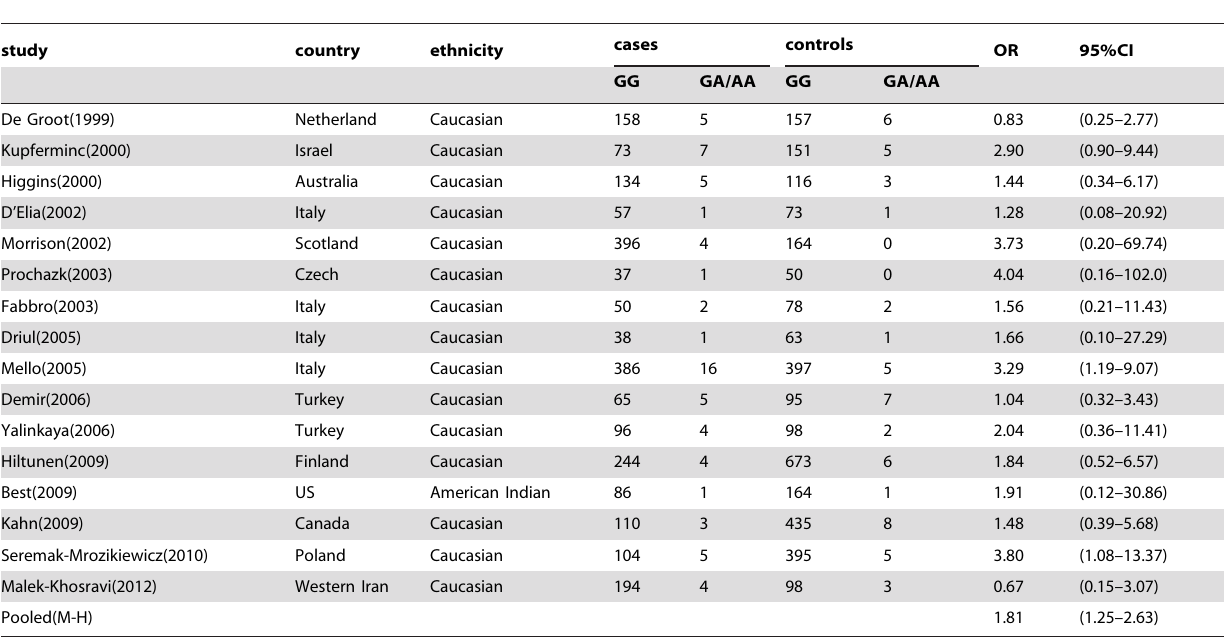
Table 1. Case-control studies of Prothrombin 20120 G-A Polymorphism and All Preeclampsia.